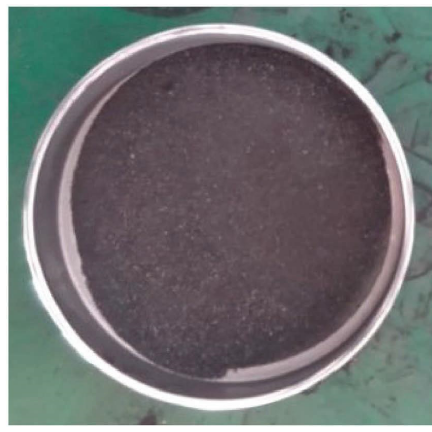
Figure 2: Nonstick coal dust sample. Table 1: Main components of a nonstick coal dust sample. Proximate analysis (%)